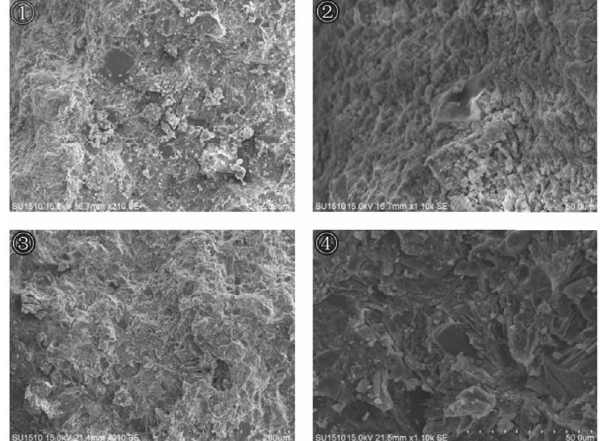
Figure8:SEMphotoofunsinteredsamples(HLWpH=7, AB Fe 2 O 3 free, CD 9% Fe 2 O 3 addition).